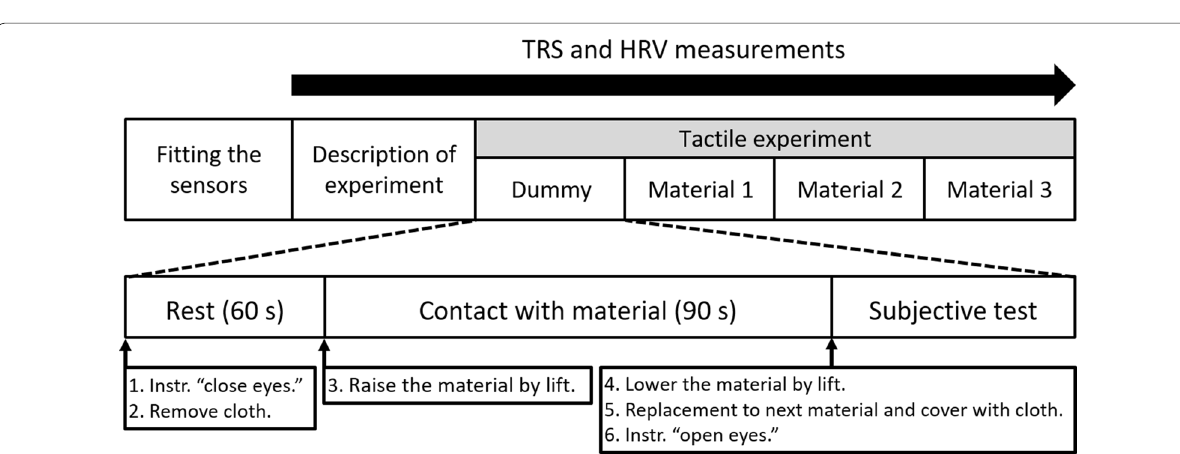
pre-measurement values (mean 30 s). In addition, the total hemoglobin (total Hb) and deoxygenated hemo- globin (deoxy-Hb) concentrations were measured and calculated as described for the oxy-Hb concentration.